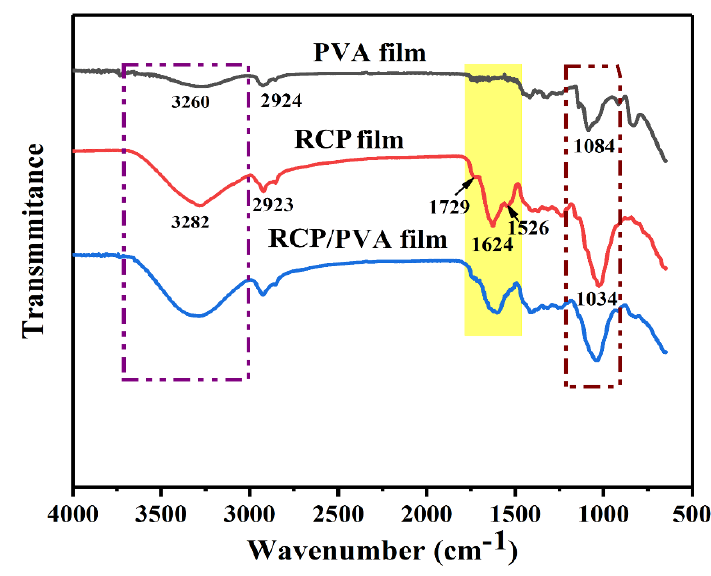
Figure 4. FT − IR spectra of PVA, RCP, and RCP/PVA films.